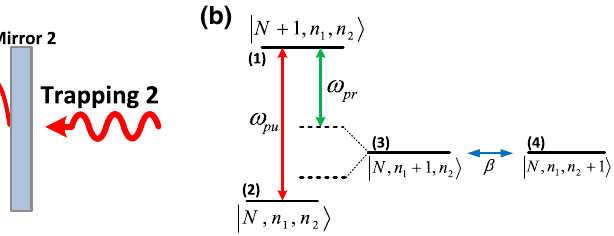
placed at the antinodes of cavity field with a separation of r 0 = 8 µ m .